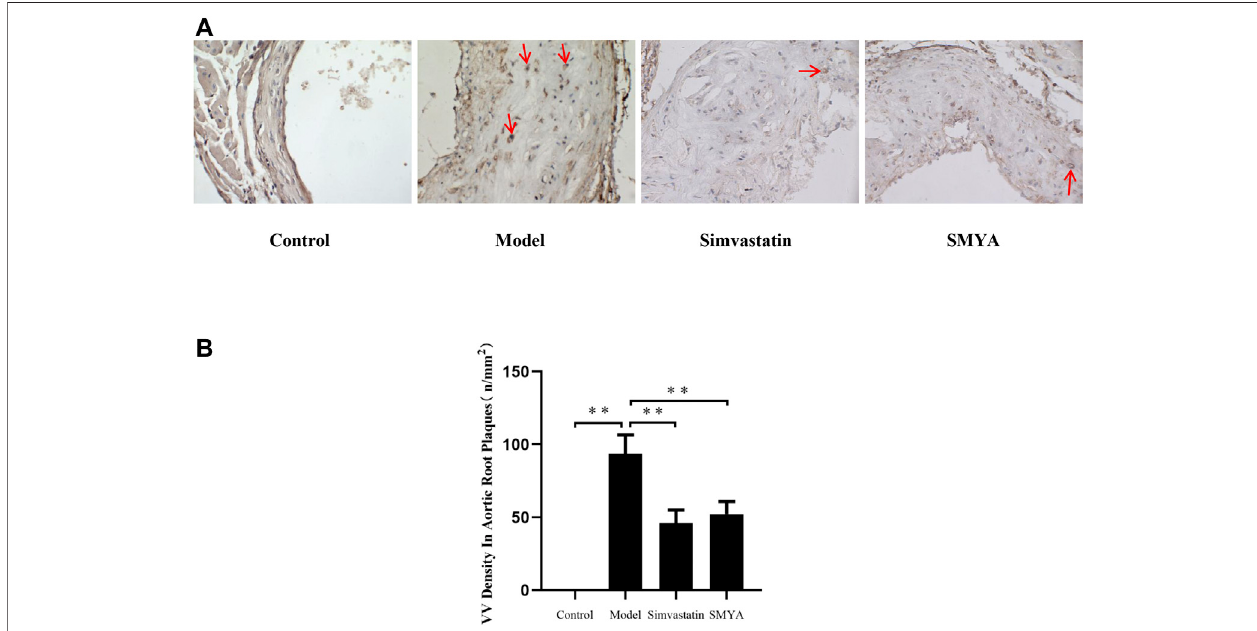
FIGURE4| EffectofSMYA onVVdensityinaortic rootplaques. (A) immunohistochemicalstainingshowed: compared withthecontrolgroup, thedensityofCD34 positive stained VV in aortic root plaques was signi fi cantly increased in model group. Compared with the model group, the VV density in aortic root plaques was signi fi cantlydecreasedinboththesimvastatinandSMYAgroups.RedarrowsmarkedtheVVneovascularizationinplaque(Magni fi cation, × 400). (B) quantitativeanalysis of SMYA on VV density in aortic root plaques. Data are expressed as mean ± SD. **p < 0.01.